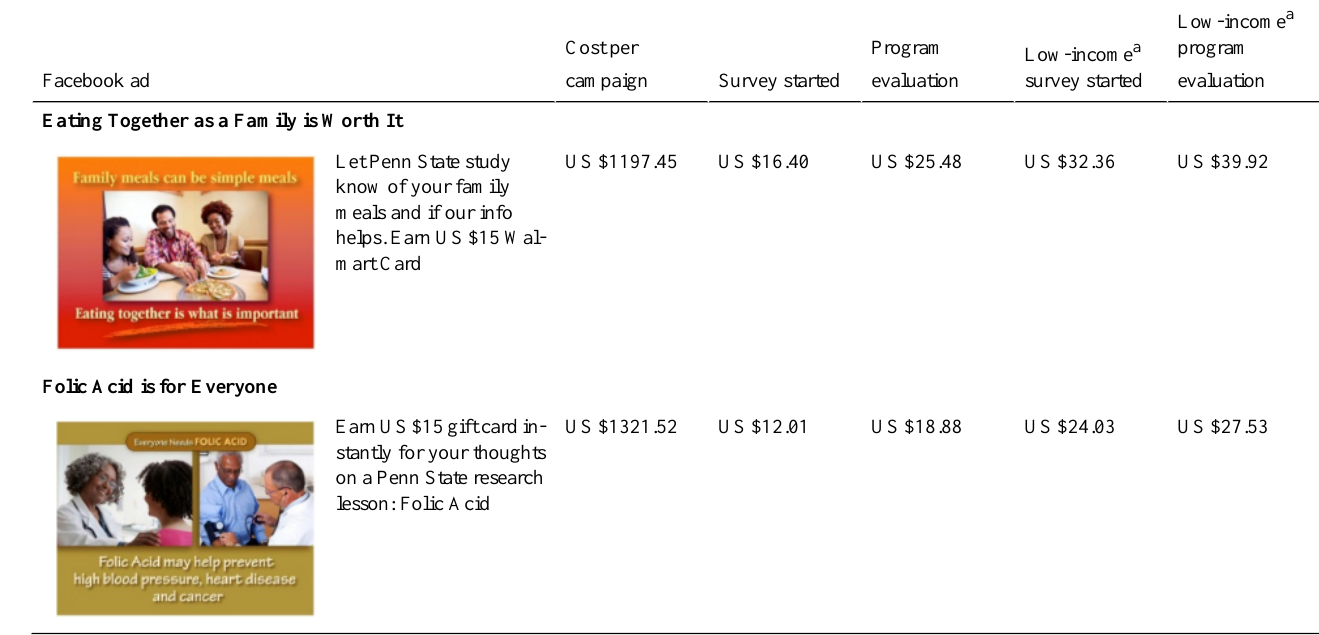
Table 1. Facebook